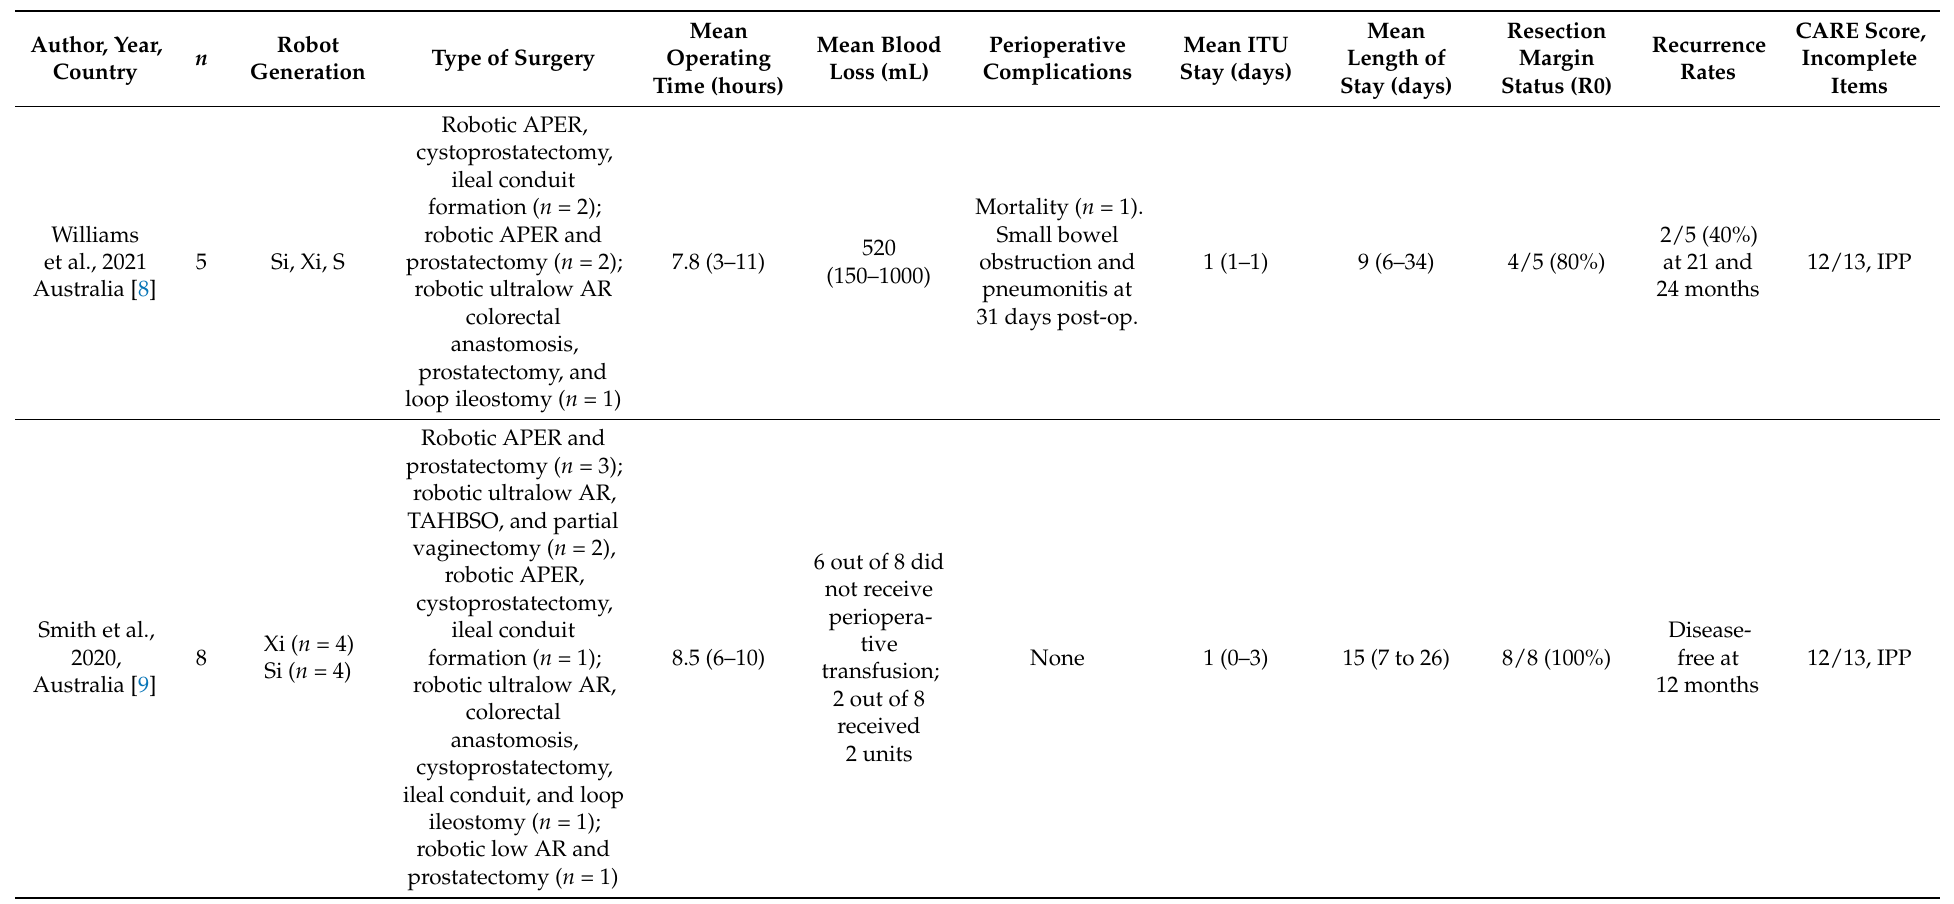
Table 1. Original studies utilising da Vinci ® Surgical System for multivisceral pelvic exenteration surgery for locally advanced including recurrent rectal